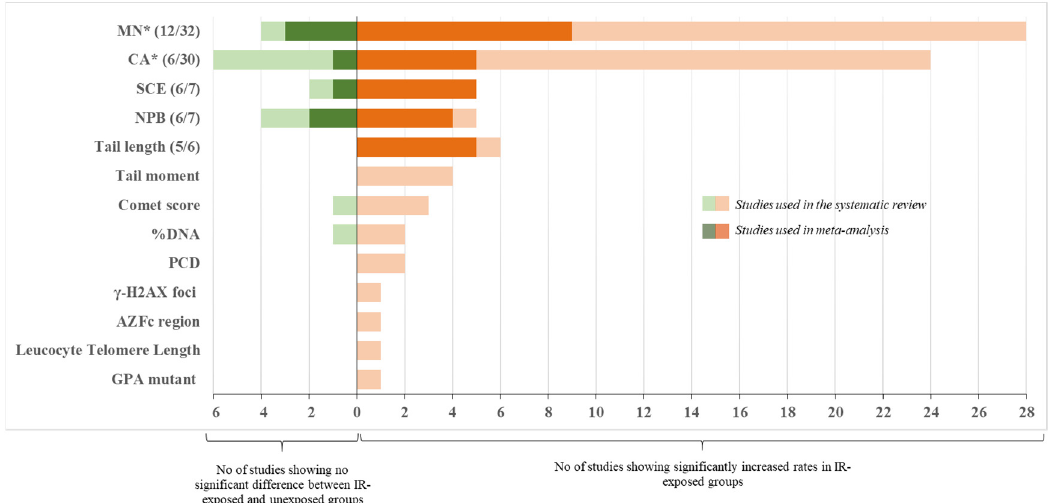
Figure 2. Summary chart of the included studies. Shown are numbers of studies broken by endpoint. Studies that reported significant increase in endpoints in IR-exposed groups are plotted to the right of the X = 0, whereas studies showing no difference are plotted to the left. Studies used in meta-analysis are shown in dark color and their numbers are also shown in the brackets (e.g., 6/7 means 6 out of 7 total studies qualified and were used in meta-analysis). * Correlation of the endpoint with other confounding factors (alcohol consumption, smoking) were reported (see text for detail). AZFc: azoospermia factor region c; CA: chromosome aberration; GPA: glycophorin A; MN: micronucleus; NPB: nucleoplasmic bridge; PCD: premature centromere divisions; SCE: sister chromatid exchange.